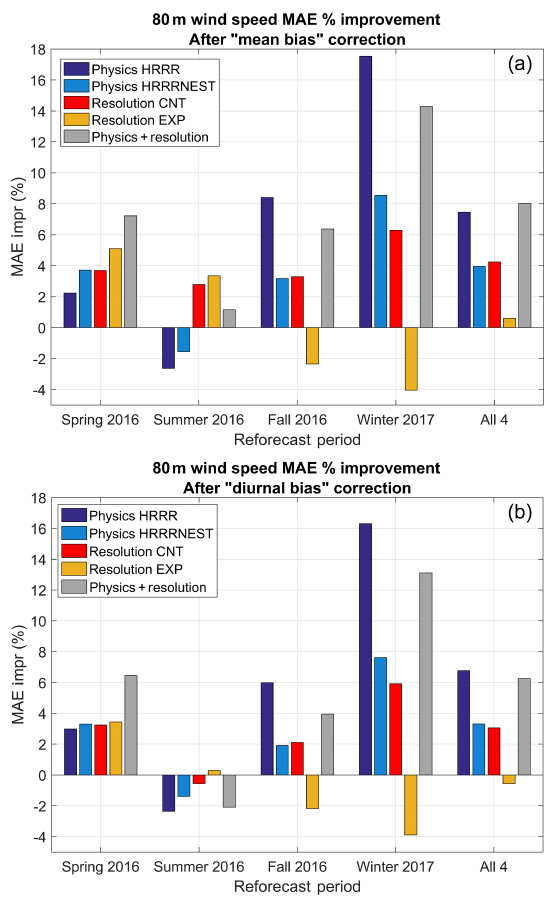
Figure 14. Percentage improvements on 80m wind speed MAE (after bias correcting the model output) due to the experimental physics, finer horizontal grid spacing, and the combination of the two for the four reforecast periods separately and averaged together. Panel (a) : results using a mean bias correction; panel (b) : results us- ing a diurnal bias